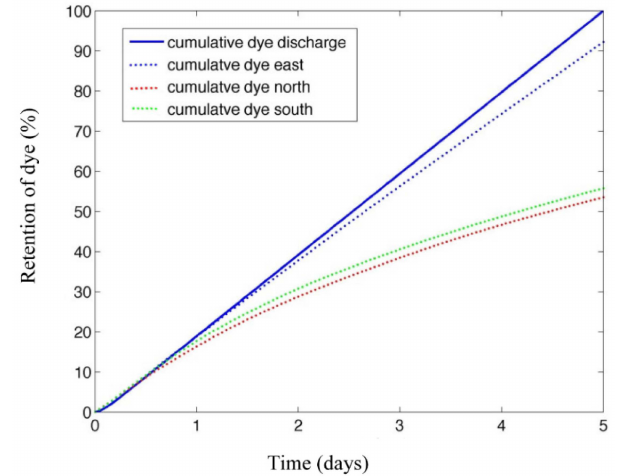
Figure 4. Percent retention of dye versus time under different wind conditions (easterly—blue dotted, northerly—red dotted, and southerly winds—green dotted). Values correspond to average for the dye release locations shown in Figure 3.